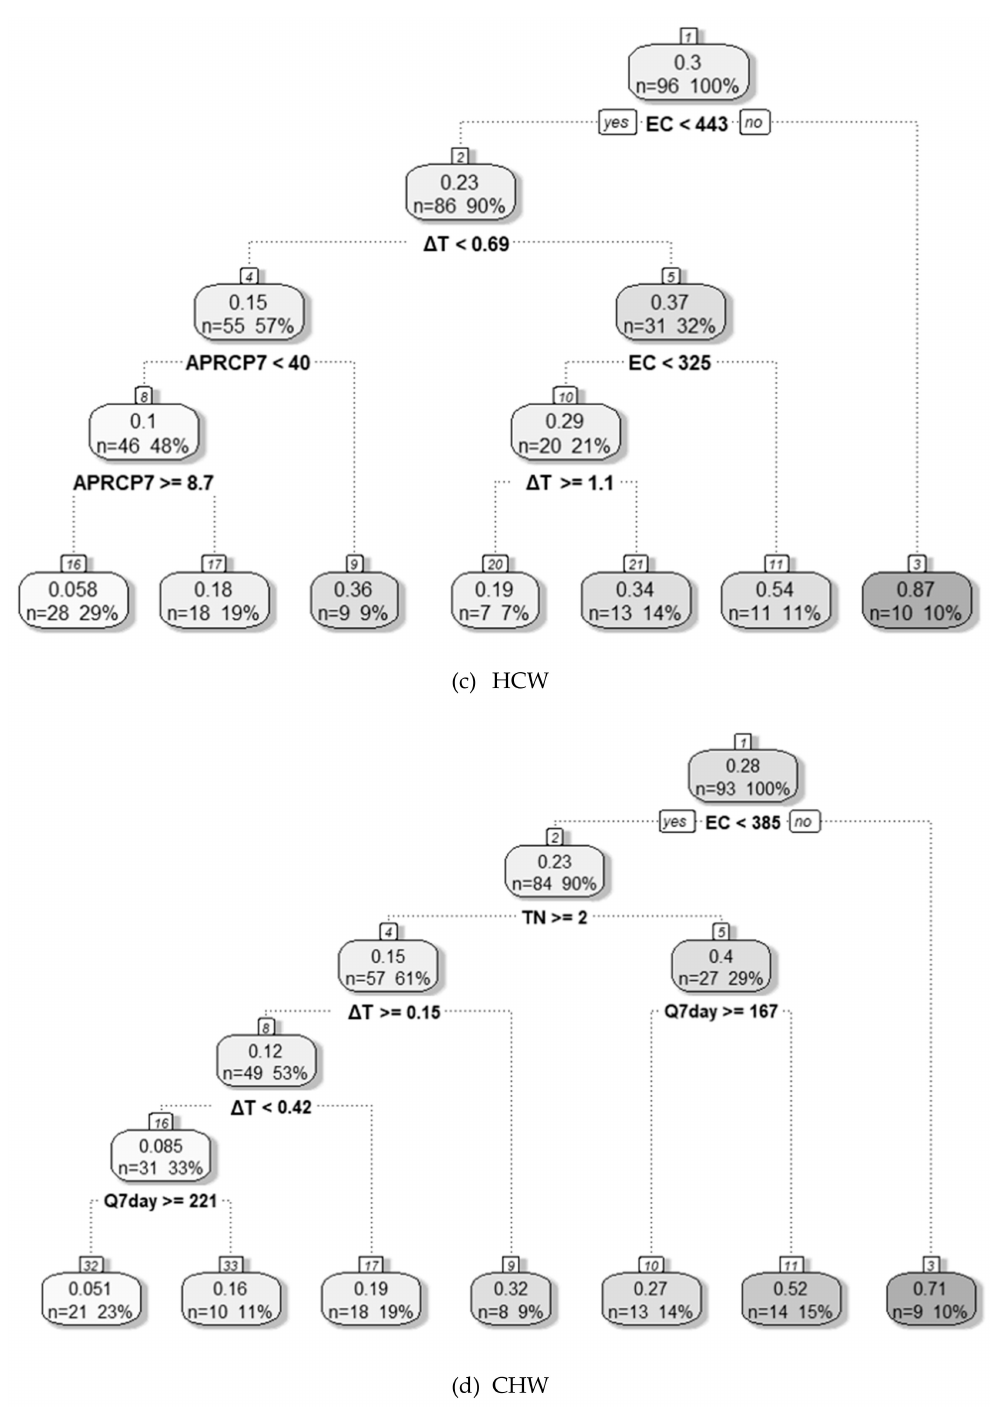
Figure 6. Evaluation of environmental conditions for high cyanobacterial dominance using a decision tree model; ( a ) Gangjeong Goryeong weir (GGW), ( b ) Dalseong weir (DSW), ( c ) Hapcheon Changnyeong weir (HCW), and ( d ) Changnyeong Haman weir (CHW). Note: see the main text for definitions of abbreviated